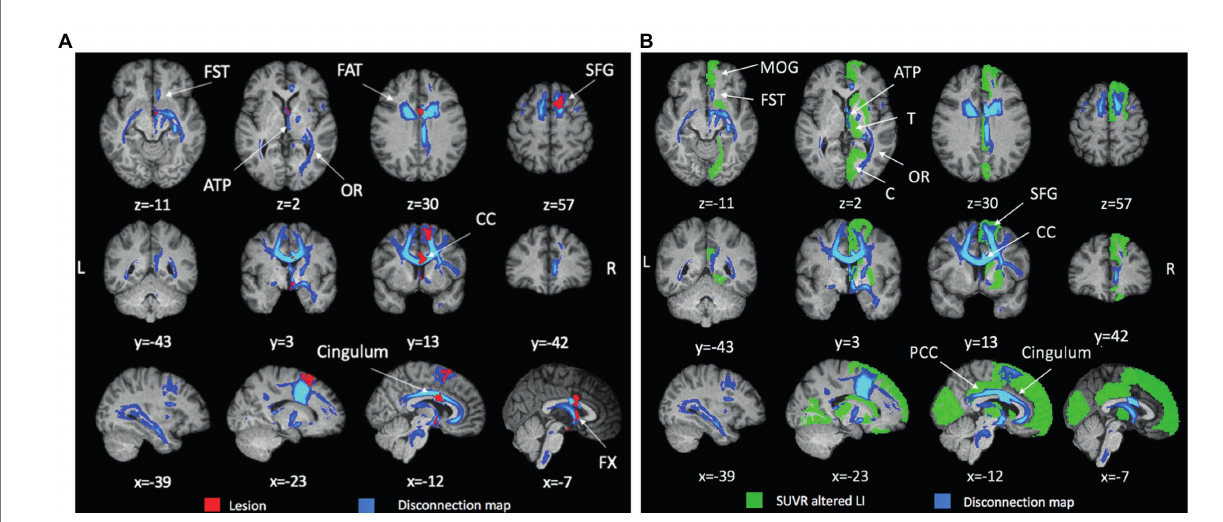
FIGURE 1 Anatomical lesion, structural disconnection map and metabolic asymmetry. (A) Anatomical lesion and associated structural disconnection map. T1- weighted structural MRI scan showing the anatomical lesion (red) in the midline frontal structures and the associated structural disconnection (blue) extending posteriorly and contralaterally (FST, fronto-striatal tract; ATP, anterior thalamic projection; OR, optic radiation; FAT, fronto-aslant tract; SFG, superior frontal gyrus; CC, corpus callosum). (B) Structural disconnection and metabolic asymmetry . T1-weighted structural MRI scan showing the structural disconnection (blue, threshold 20%) and regions with significative metabolic asymmetry (>2SD; green; SFG, medial orbital gyrus (MOG), caudate, putamen, thalamus (T), posterior cingulate cortex (PCC), cuneus, lingual